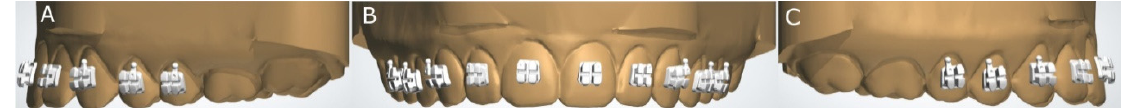
Figure 1. ( A ) Lateral left, ( B ) frontal, and ( C ) lateral right view of the fixed buccal multibracket appliances digitally planned on the experimental anatomically based models.